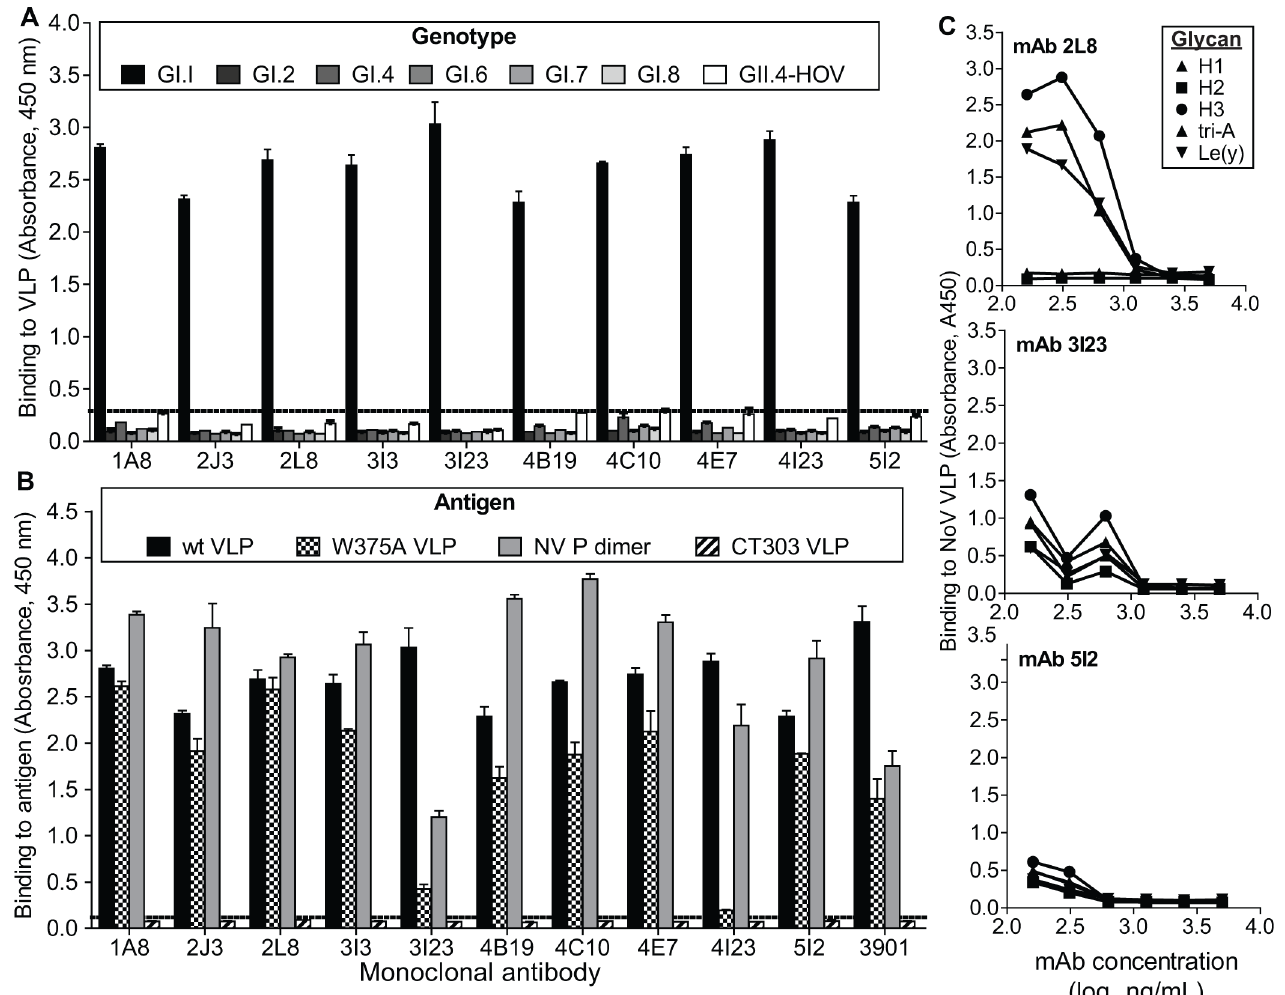
Fig 3. Specificity of human mAbs. The binding (mean absorbance at 450 nm ± SD) of purified mAbs at 20 μ g/mL to VLPs representing homologous virus (NoV GI.I) or heterologous human NoVs of different genotypes (A) or antigens representing wild-type or mutant recombinant capsid proteins of homologous virus (B) were assessed by ELISA to evaluate genotype specificity and to infer the subdomain of major capsid protein bound by anti-norovirus mAbs. The data shown in each figure summarizes the results from 2 independent experiments. (C) The ligand specificity of mAb-mediated inhibition of NoV VLP binding to a panel of its glycan ligands (H1, H2, H3, tri-A or Le(y)) was evaluated in HBGA blocking assay for three mAbs, 2L8, 3I23 and 5I2.